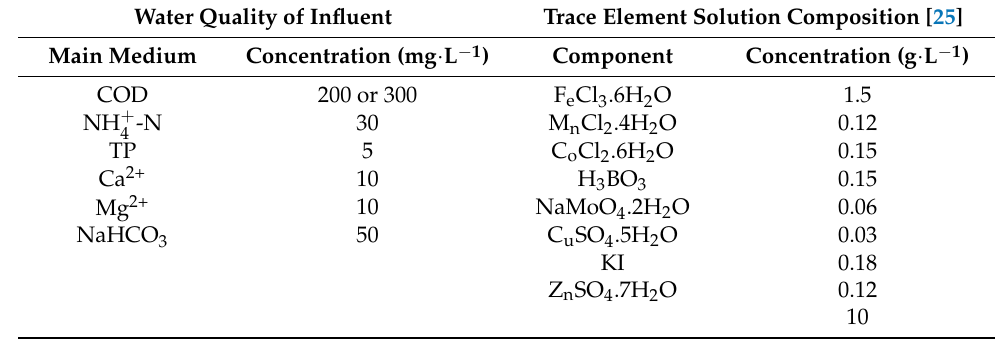
Table 2. Composition of influent in the SNDPR